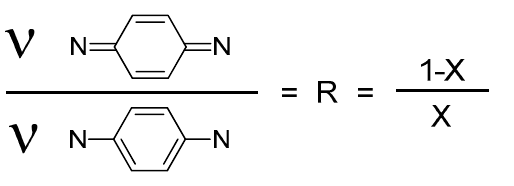
Figure 11. Oxidized and reduced units.